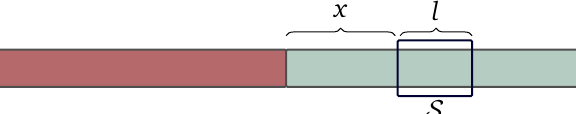
Figure 2: Sketch of the inhomogeneous quench setup considered in Sec. 5. We con- sider the dynamics after a bipartitioning protocol of a finite subsystem S of size l is at distance x from the